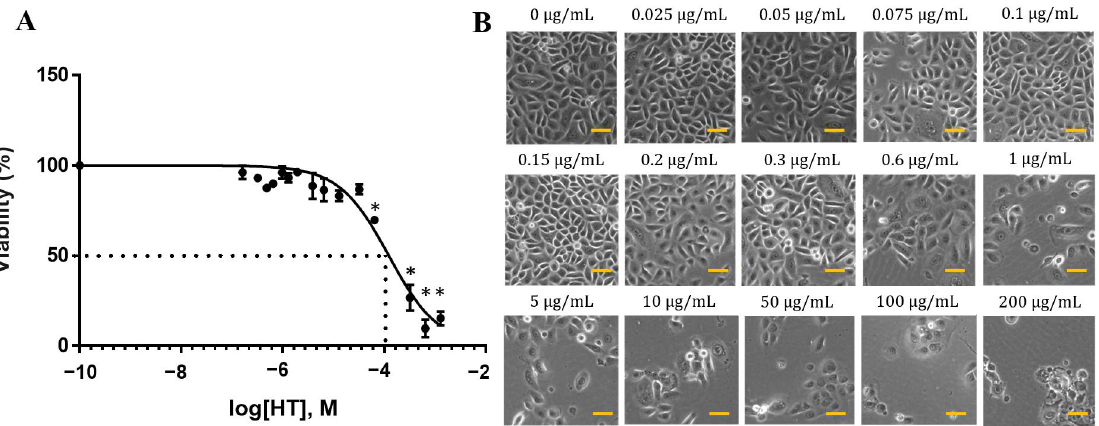
Figure 1. Dose-dependent effect of HT on RECs. RECs were treated with HT for 24 h, and cell viability was analyzed via MTT assay. ( A ) MTT assay of HT cytotoxicity. * p < 0.05: significantly different from control (0 µ g/mL) (Supplementary Material Table S1). ( B ) Morphology of RECs treated with HT for 24 h. Scale bar represent 100 µm.